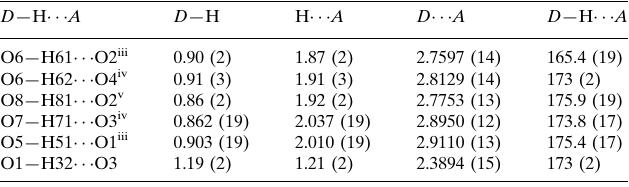
Hydrogen-bond geometry (A˚ , (cid:4)